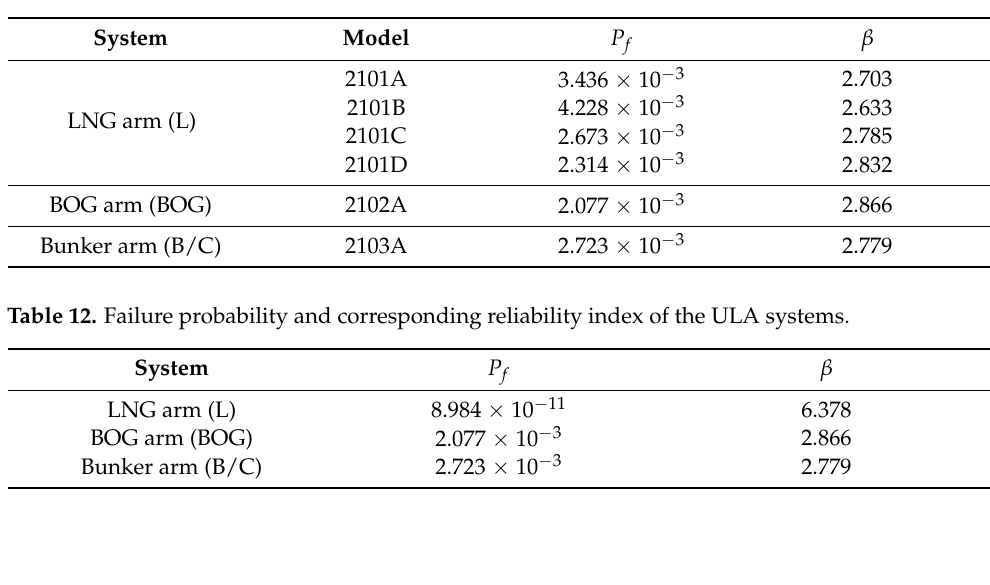
Figure 12. The distributed system of ULA Components. Table 11. Failure probability and corresponding reliability index of the ULA models.